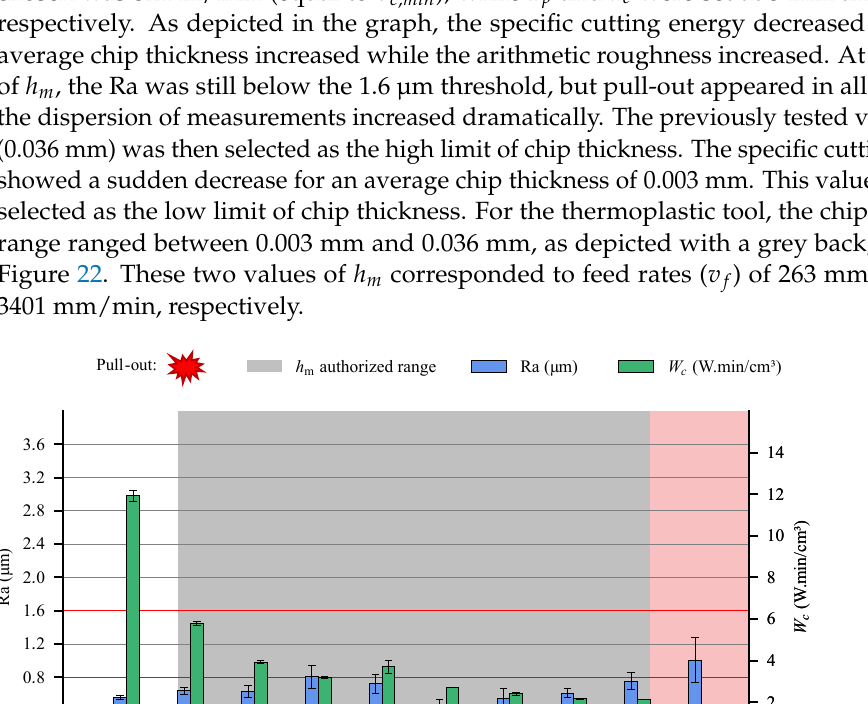
Figure 22. Evolution of the specific cutting energy (W · min/cm 3 ) and Ra (µm) of the thermoplastic tool for different h m (mm) with v c = 324 m/min, a p = 3 mm, and a e = 0.5 mm. Figure 23 allows the determination of the low and high limits of chip thickness for the composite tool. As for the thermoplastic tool, v c was chosen equal to v c , min (351 m/min), while a p and a e were set at 3 mm and 0.5 mm, respectively. As expected, W c and its measurement dispersion decreased when h m increased. In contrast with the thermoplastic tool, the arithmetic roughness achieved values higher than the 1.6 µm threshold for low values of h m . The first chip thickness leading to a Ra below the threshold was 0.003